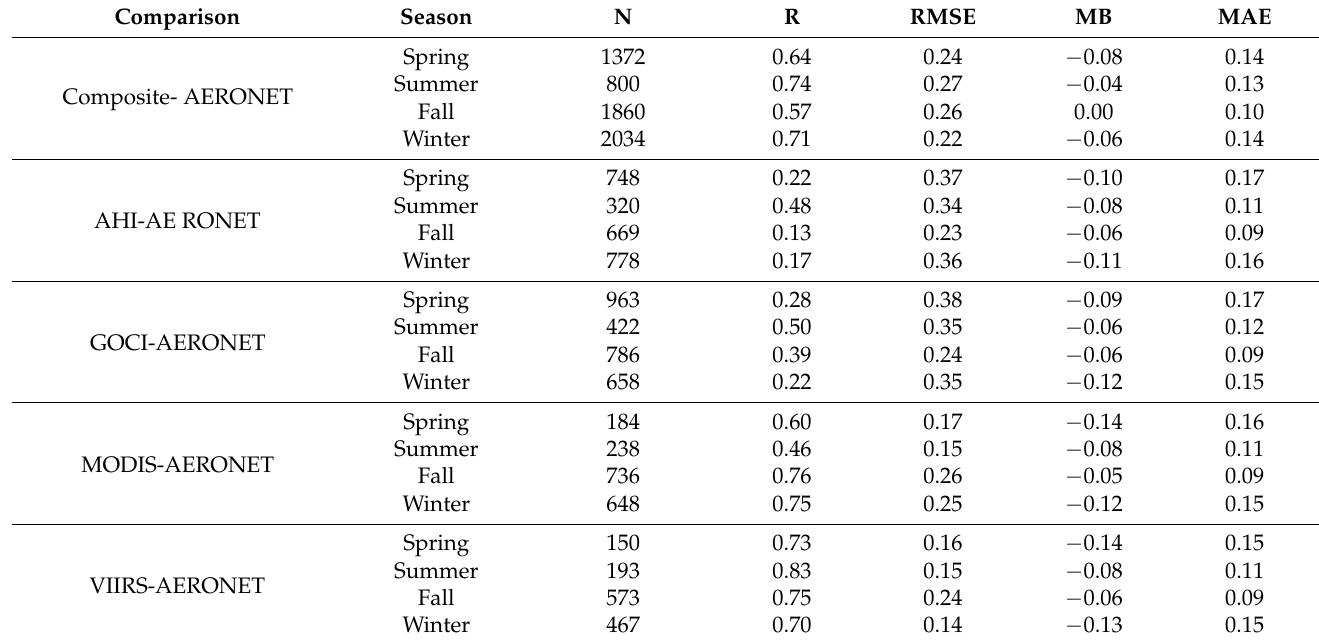
Table A5. Seasonal comparison statistics for composite, satellites, and AEORNET AOD products at 500 nm from January to December 2017.